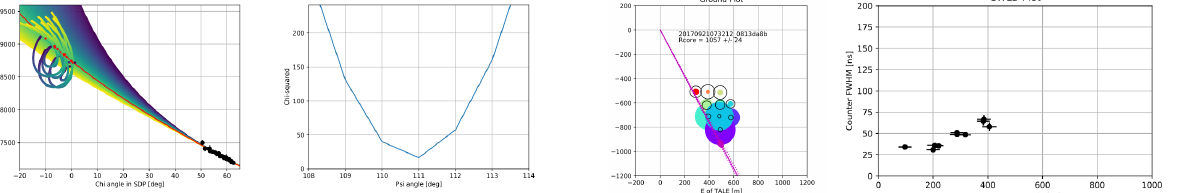
Figure 6. Left: The size, timing and FWHM of NICHE events in a single coincident event. The size of the colored circles shows the size of the signal in the NICHE counter, while the color shows the relative time, from purple to red. The size of the black cir- cle is proportional to the FWHM of the signal. The purple solid and dotted lines show the projection of the TALE shower detec- tor plane onto the ground with errors, and the purple dots show the most likely core position with errors. Right: The FWHM of NICHE signals versus distance from the shower axis for all NICHE counters.